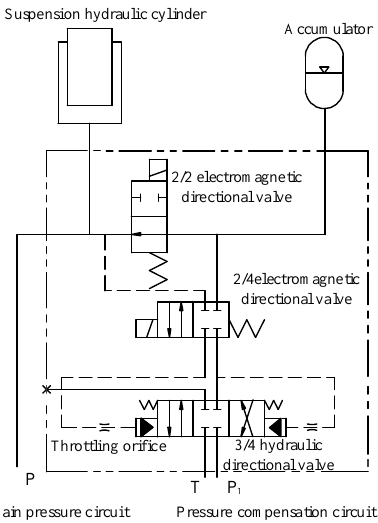
Figure 5. The schematic diagram of the accumulator setting.